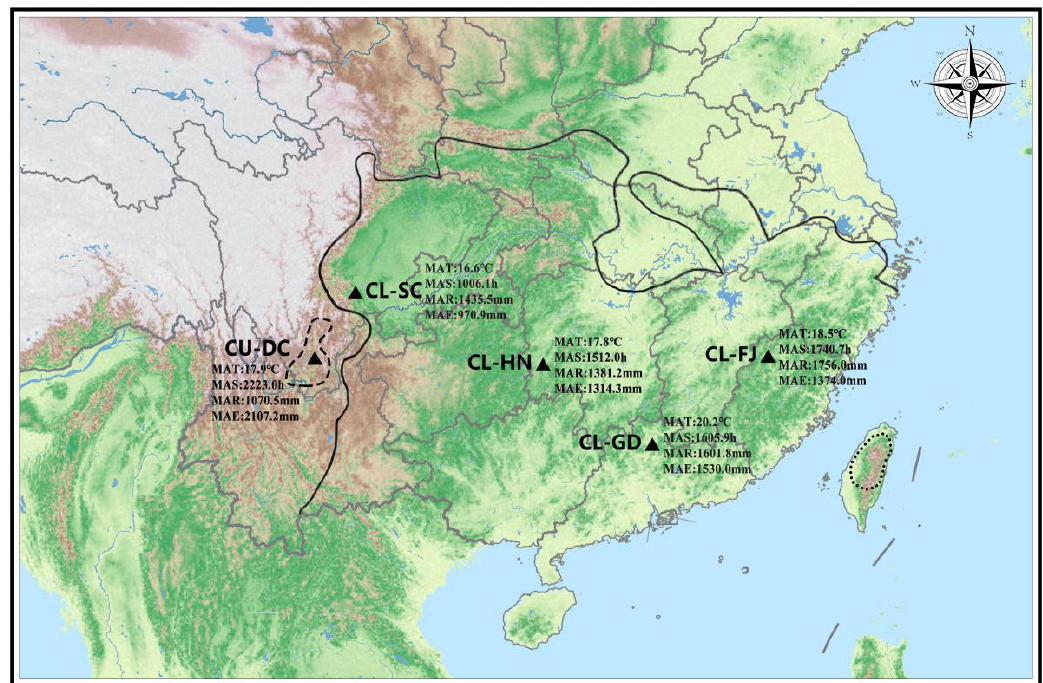
Figure 1. The distribution area of Cunninghamia and sources of experimental materials with local climate data. Solid line represents the distribution area of C. lanceolata , dash line represents the distribution area of C. unica , dot line represents the distribution area of C. konishii . MAT: mean annual temperature; MAS: mean annual sunshine duration; MAR: mean annual rainfall; MAE: mean annual evaporation.